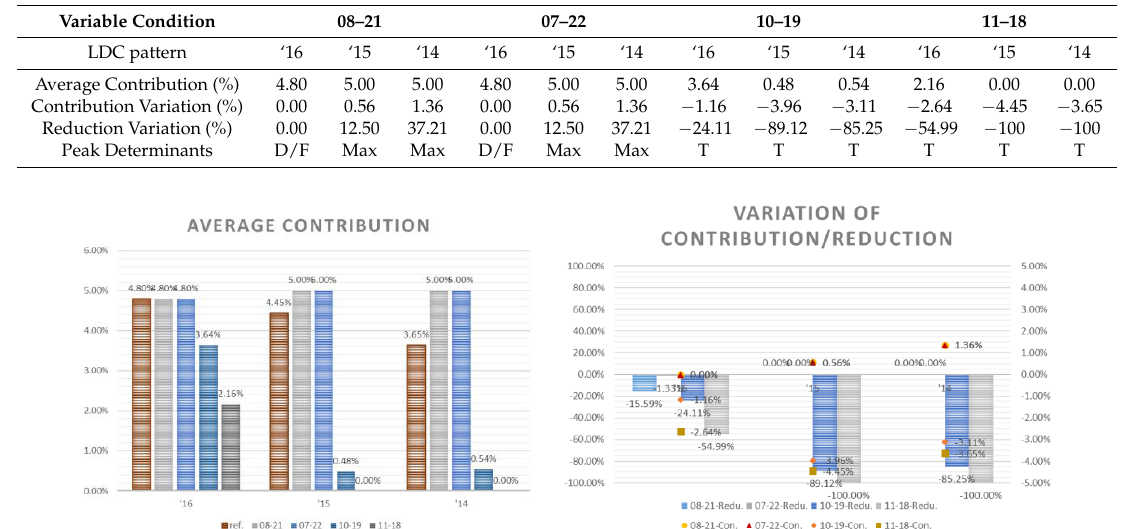
Table 8. Summary of sensitivity simulation results with dispatchable Time.